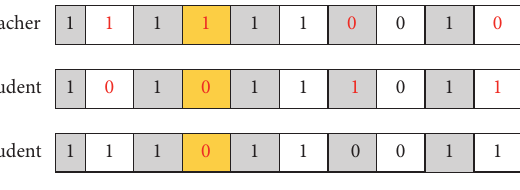
Figure 3: Crossover operator.